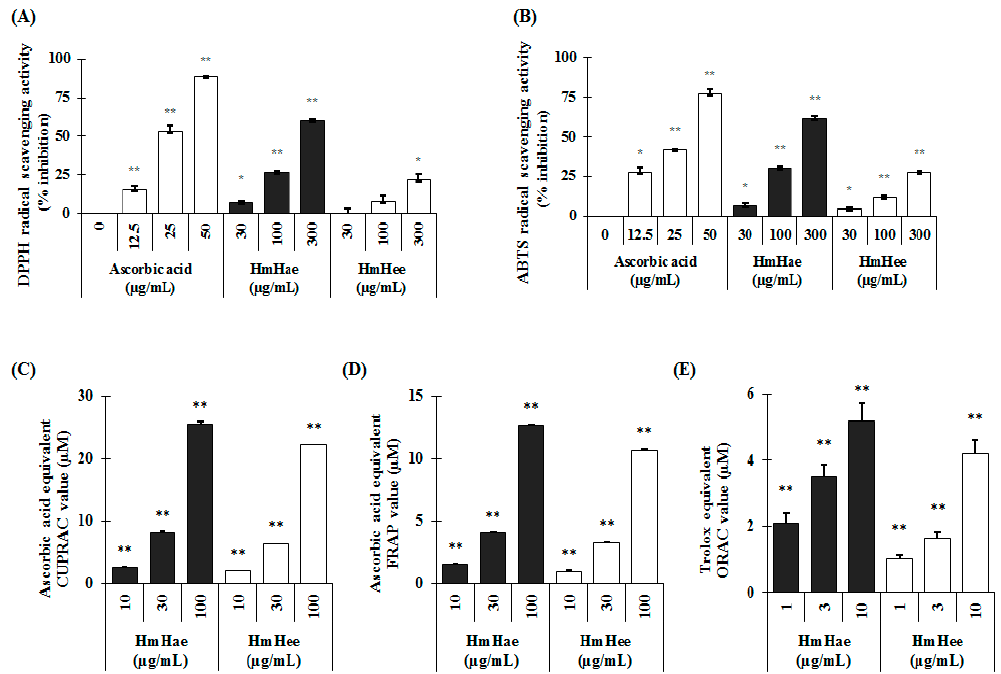
Figure 2. Antioxidant properties of Heracleum moellendorffii Hance by various in vitro antioxidant assays. DPPH radical scavenging activity ( A ); ABTS radical scavenging activity ( B ); CUPRAC activity ( C ); FRAP activity ( D ) and ORAC activity ( E ) were analyzed as described in detail in Materials and Methods. Each experiment was performed in triplicate and the data shown represent the mean ± SD. * p < 0.05, ** p < 0.01, student’s t -test.